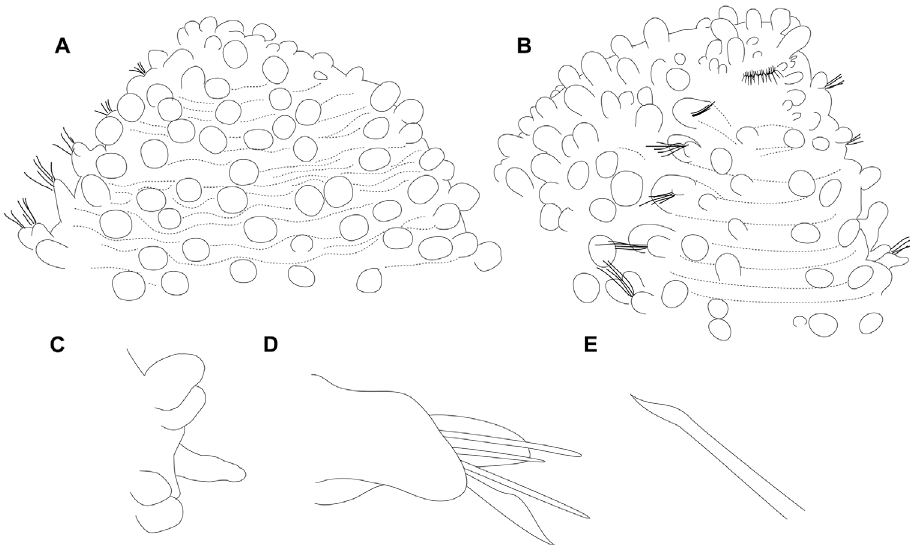
Figure 4. Euritmia carolensis sp. n., holotype, USNM 1001792, drawings. A Anterior end, dorsal view B Same, lateroventral view C Pygidium, side view D Mid-body parapodium, dorsal view E Detail of